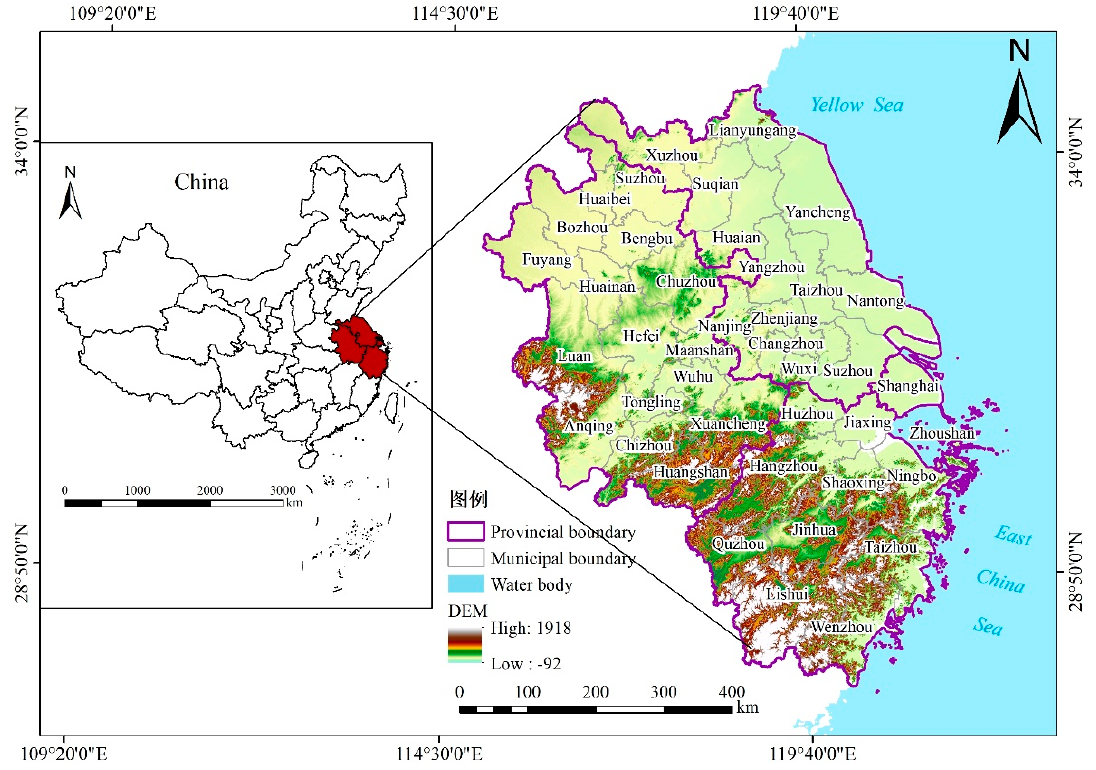
Figure 1. The map of the Yangtze River Delta region (YRD).